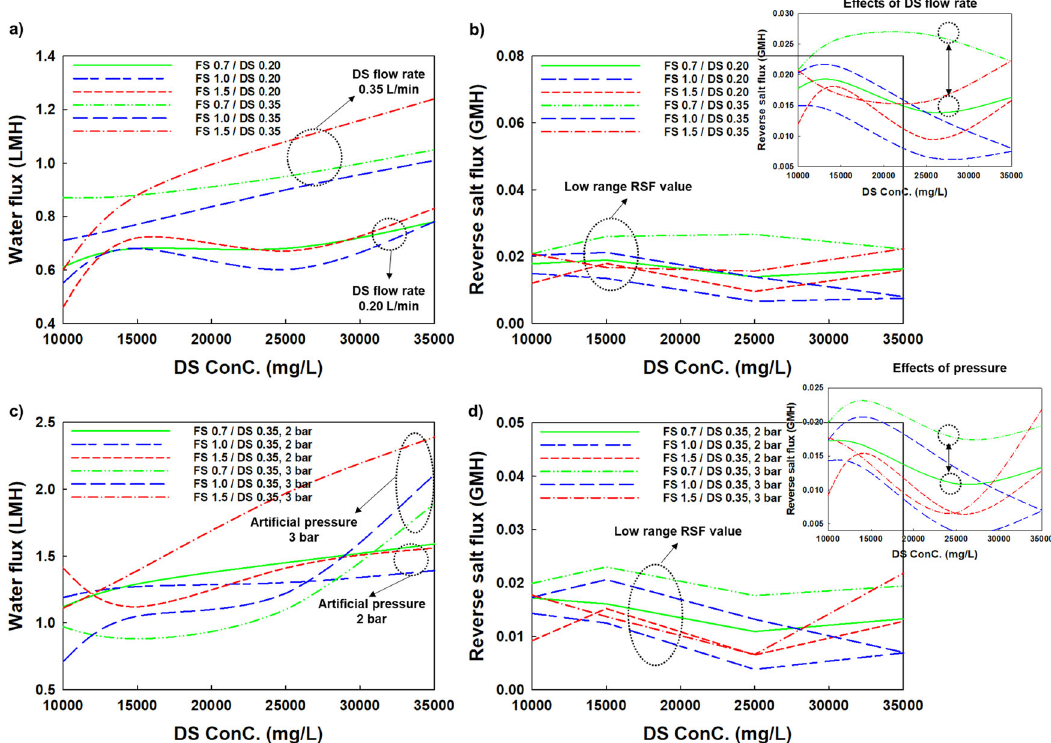
Fig. 1 Water fl ux and RSF variation at various operation conditions without ionic strength in FS. Panels a , b show the water fl ux and RSF variation at the FO mode and panels c , d show the PAO mode. Concentration and pressure conditions: FO mode (DI water as FS, synthetic seawater (10,000 to 35,000 NaCl mg/L) as DS, and pressure of 0 bar) and PAO mode (DI water as FS, synthetic seawater (10,000 to 35,000 NaCl mg/L) as DS, and pressure of 2 and 3 bar). Flow rates: FO mode (FS: 0.7, 1.0, and 1.5 L/min and DS: 0.20 and 0.35 L/min) and PAO mode (FS: 0.7, 1.0, and 1.5 L/min and DS: 0.35